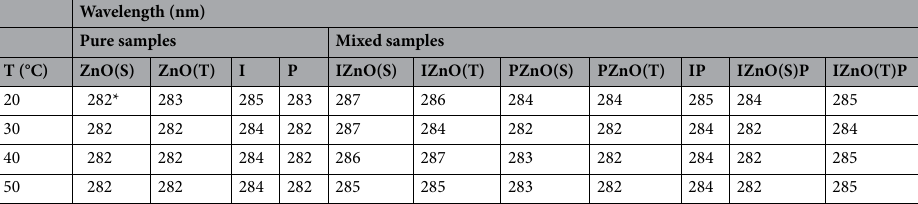
Table 1. The measured wavelength corresponding to the absorbance peak of all samples at various temperatures (20 °C, 30 °C, 40 °C and 50 °C) using UV spectrophotometer.